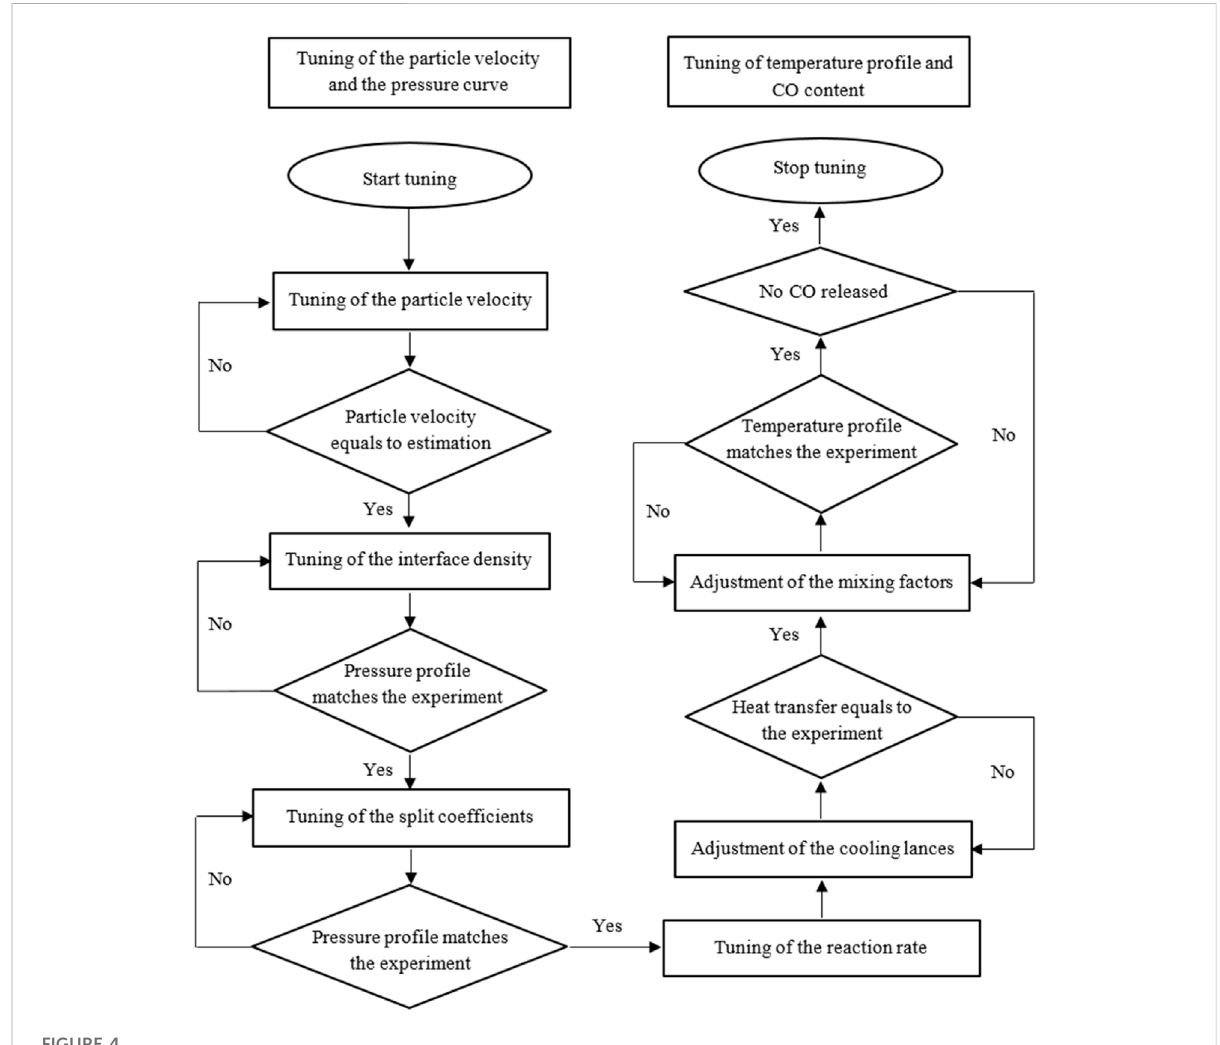
FIGURE 4 Flowchart of the tuning process.